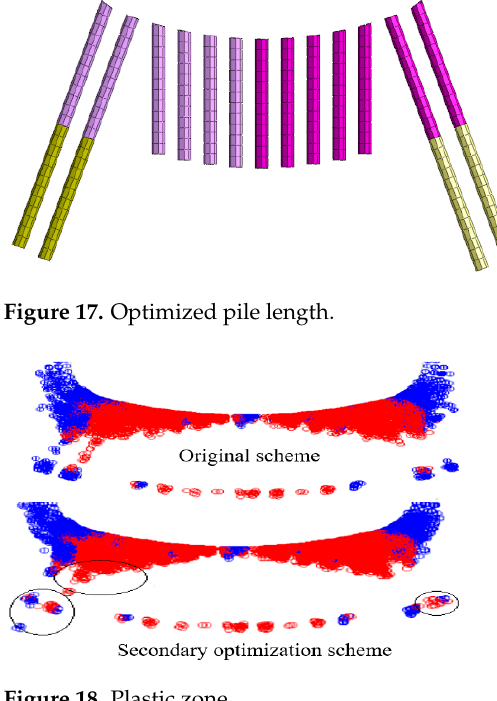
Figure 16. Differential settlement under different schemes.